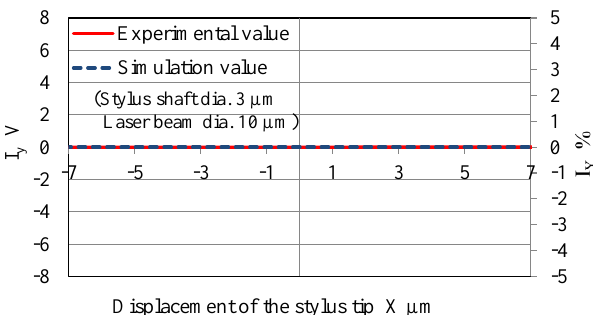
Figure 14. Simulation and experimental results for I Y for a distance of L 1 = 40 mm ( X displacement of the stylus tip).